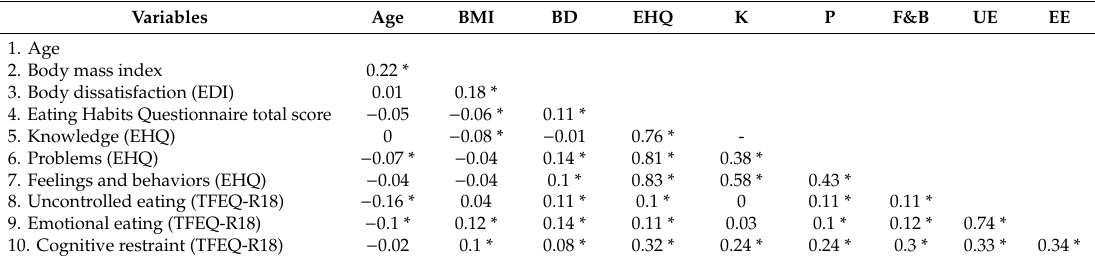
Table 4. Correlations for study